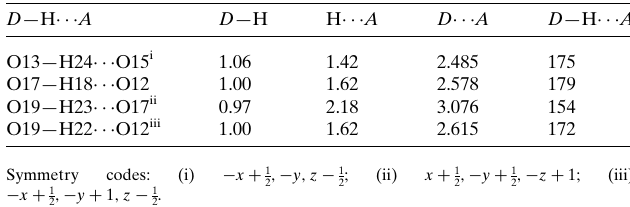
Table 1 Hydrogen-bond geometry (A˚ , (cid:3) ) for (I) (DFT).